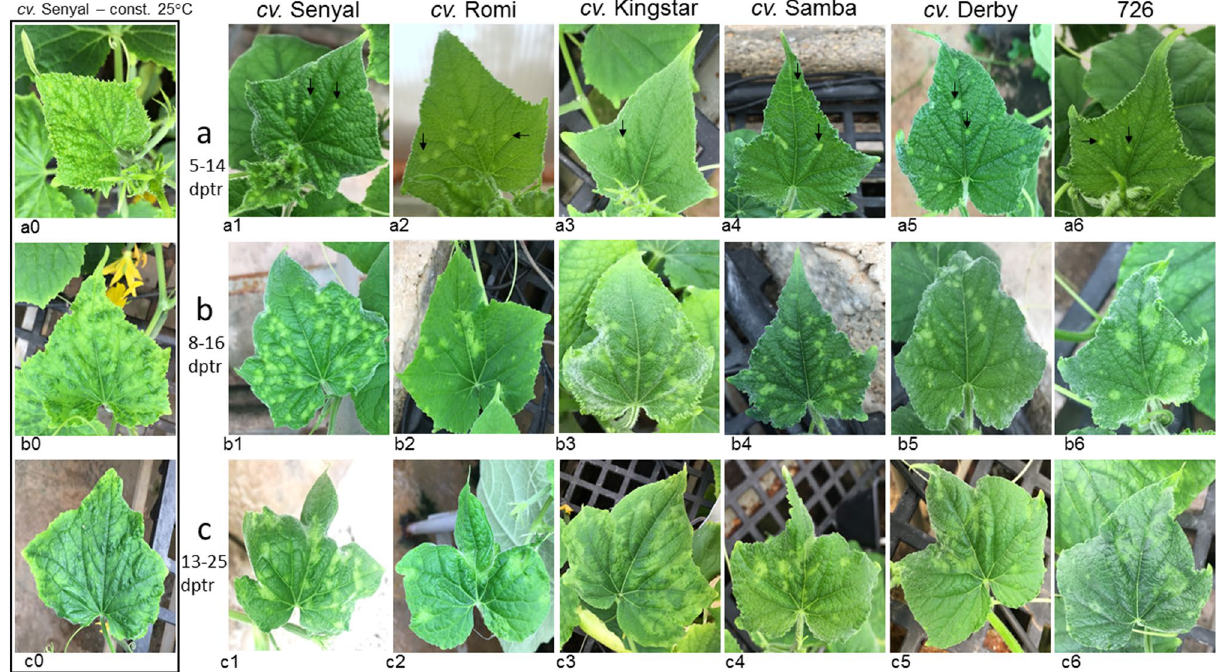
Figure 1. Development of ’bright yellow islands’ (BYIs) and reemerging CGMMV disease symptoms on recovered cucumber leaves. ( a ) ’Early post-recovery stage’ observed at 5–14 dptr. ( b ) ’ Late post-recovery stage’ observed at 8–16 dptr. ( c ) ’Second symptomatic stage’ observed at 13–25 dptr. ( a0–c0 ) CGMMV-infected cucumber plants cv . Senyal kept at a constant 25 °C growth chamber showing mottling mosaic symptoms. ( a1– a6 ) BYIs at the ’early post-recovery stage’ showing defined boundaries. ( b1–b6 ) BYIs at the ’late post-recovery stage’ showing diffused boundaries. ( c1–c6 ) Reemerging symptoms of the combined phenotype of yellow patched mottling and mosaic on slightly deformed leaves at the ’second symptomatic stage’. ( a1 , b1 , c1 ) cv . Senyal; ( a2 , b2 , c2 ) cv . Romi; ( a3 , b3 , c3 ) cv . Kingstar; ( a4 , b4 , c4 ) cv . Samba; ( a5 , b5 , c5 ) cv . Derby; ( a6 , b6 , c6 ) 726. dptr, days post temperature raise; black arrows marked ’early post-recovery stage’ between the BYIs and the corresponding dark green surrounding tissues (Fig. 2). At the ’early post-recovery stage’, RT-PCR analyses showed undetectable virus titer in the dark green asymptomatic tissues, compared to the associated BYIs (a total of 5 samples were tested) (Fig. 2a2). Similar results were obtained by western blot analyses, showing CGMMV coat protein (CP) in the BYIs, whereas the corresponding asymptomatic dark green surrounding tissues were devoid of the virus (a total of sixteen samples were tested) (Fig. 2a3–a4). In contrast, RT-PCR and western blot analyses of CGMMV at the ’late post-recovery stage’ showed that CGMMV was pre- sent in both the BYIs, with the diffused boundaries, and the corresponding dark green surrounding tissues (Fig. 2b2–b4). These results could indicate that CGMMV in ’early post-recovery stage’ BYIs with defined bound- aries overcame plant resistance when ’late post-recovery stage’ BYIs were manifested. The increase in CGMMV titer in the dark green surrounding tissue associated with ’late post-recovery stage’ BYIs compared to the asymp- tomatic dark green tissue surrounding ’early post-recovery stage’ BYIs was confirmed by RT-qPCR (Fig. 2c). Importantly, whereas viral content in early and late post-recovery stage BYIs were generally comparable, the cal- culated relative CGMMV expression ratios between the BYIs and the associated dark green surrounding tissues (B/D) showed a prominent decrease upon progression from the early to the late post recovery stages (Fig. 2d). A time-table scheme of ’Bright yellow island’ manifestations, challenged in field cultivated cucumber plants. The gradual CGMMV disease symptom manifestations following cucumber plant recov- ery, observed in all the tested cucumber cultivars that were subjected to an abrupt temperature raise, served for drawing a time-table scheme for disease progression (Supplementary Table S1, Fig. 3a,b). The gathered data specified time-windows for five phenotypic stages of CGMMV disease in cucumbers following an extreme tem- perature raise (25 ± 2 °C to 32 ± 2 °C). Time lengths between the abrupt temperature raise and severe symptom induction ranged between 5 to 48 hptr. Time lengths before reaching symptom recovery ranged between an additional 4 days (d) to 8 d. Early and late post-recovery stage BYIs appeared 2–3 d following the recovery stage. The consequential ’second symptomatic stage’, showing the combined phenotype of yellow patched mottling and mosaic, appeared after additional 4–7 d. Applying the derived CGMMV disease phenotype progression scheme to field cultivated cucumber plants revealed occurrence of BYIs following natural heat wave events. The major- ity of the commercial cucumber net-houses in Ahituv, Israel (32° 23 ′ 19.4 ″ N 34° 59 ′ 22.4 ″ E) are frequently infected with CGMMV during the three continuous yearly growing cycles. A visit to a selected commercial cucumber net-house in Ahituv, 8 days following a heat wave, disclosed the BYI phenotype in five plants, found in a cluster of ca . fifty symptomatic plants that were amid asymptomatic surroundings (Fig. 3c,d). In addition,